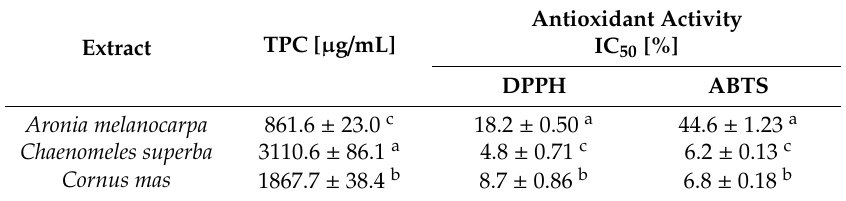
Table 1. Total phenolic content (TPC) and antioxidant activity in leaf extracts. The results are expressed as mean ±